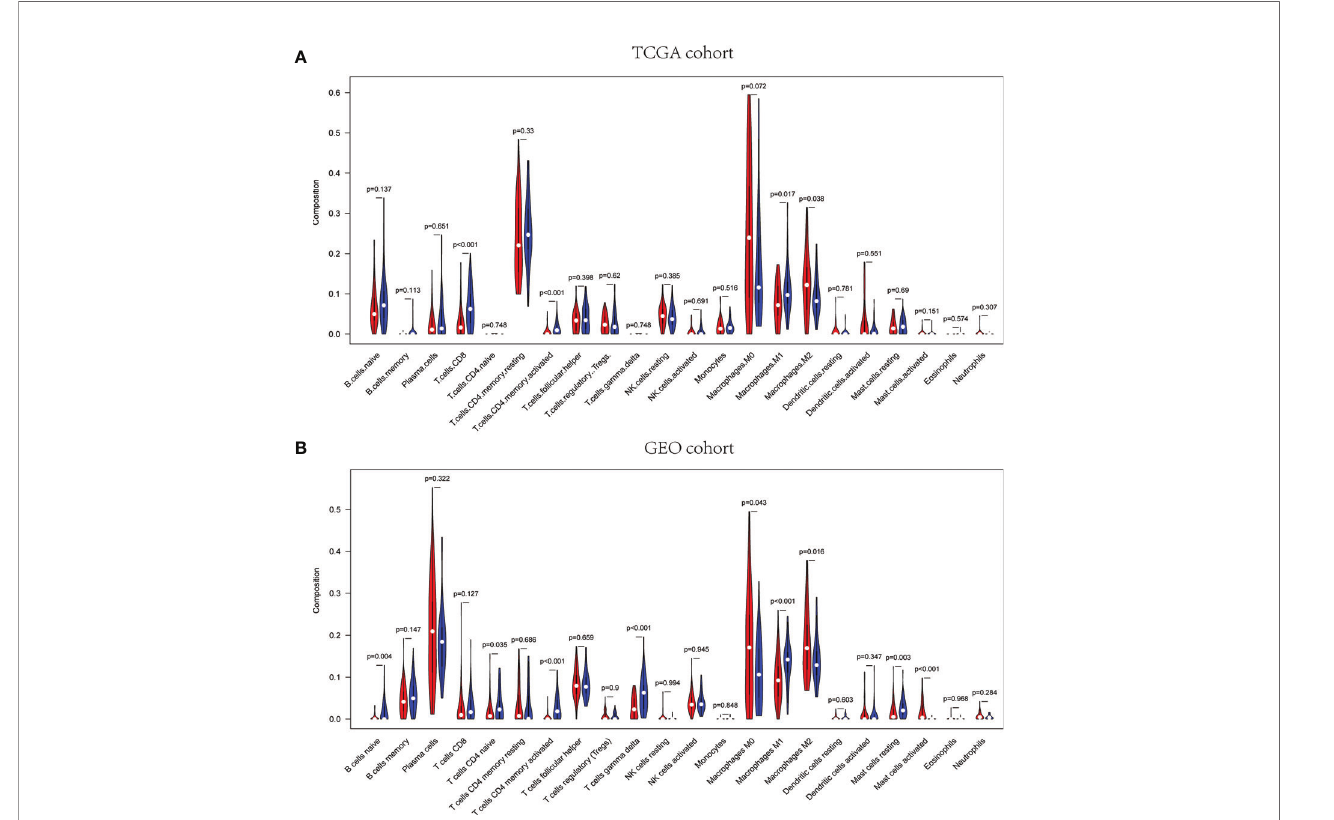
FIGURE 11 | Correlation of distinct different immune cells between high- and low-risk groups in TCGA (A) and GEO (B) ,